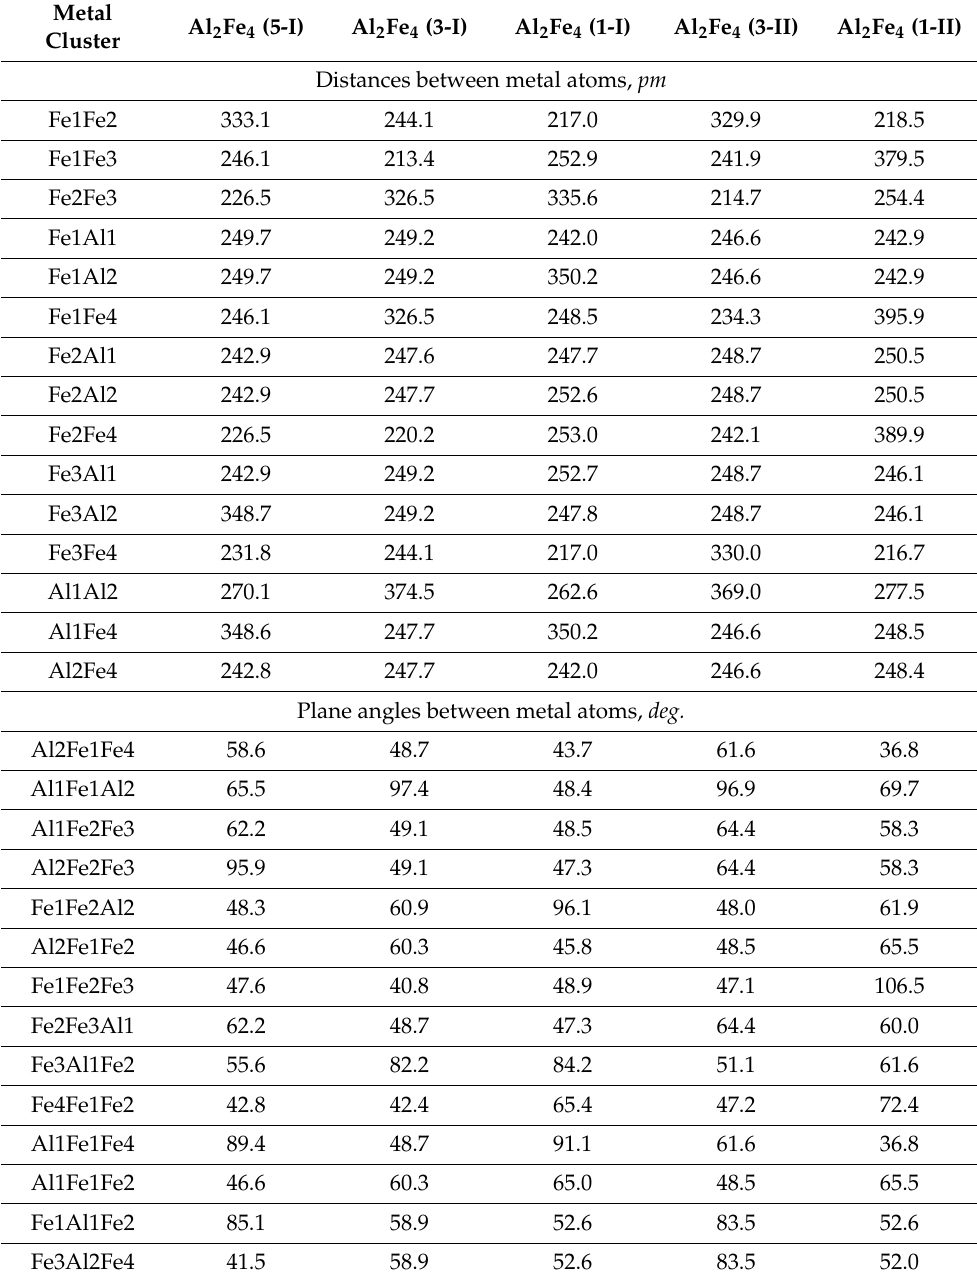
Table 8. Key structural parameters of the most stable Al 2 Fe 4 metal